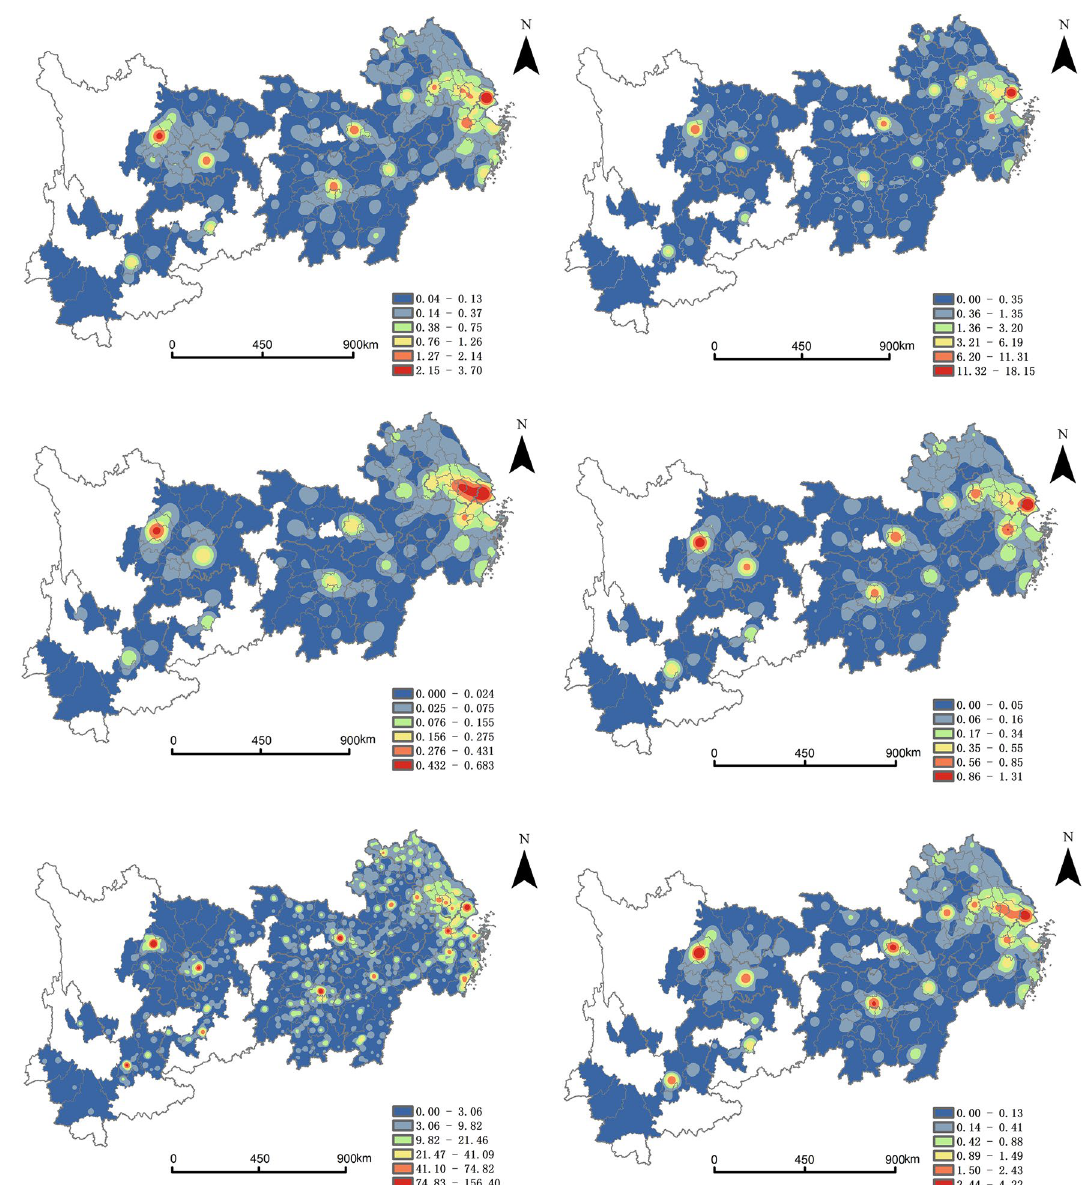
Figure 3. Kernel density of producer